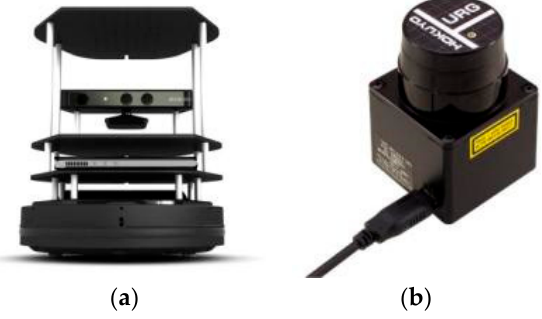
Figure 11. Experiment apparatus: ( a ) Turtlebot; ( b ) URG-04LX-UG01 laser scanner.